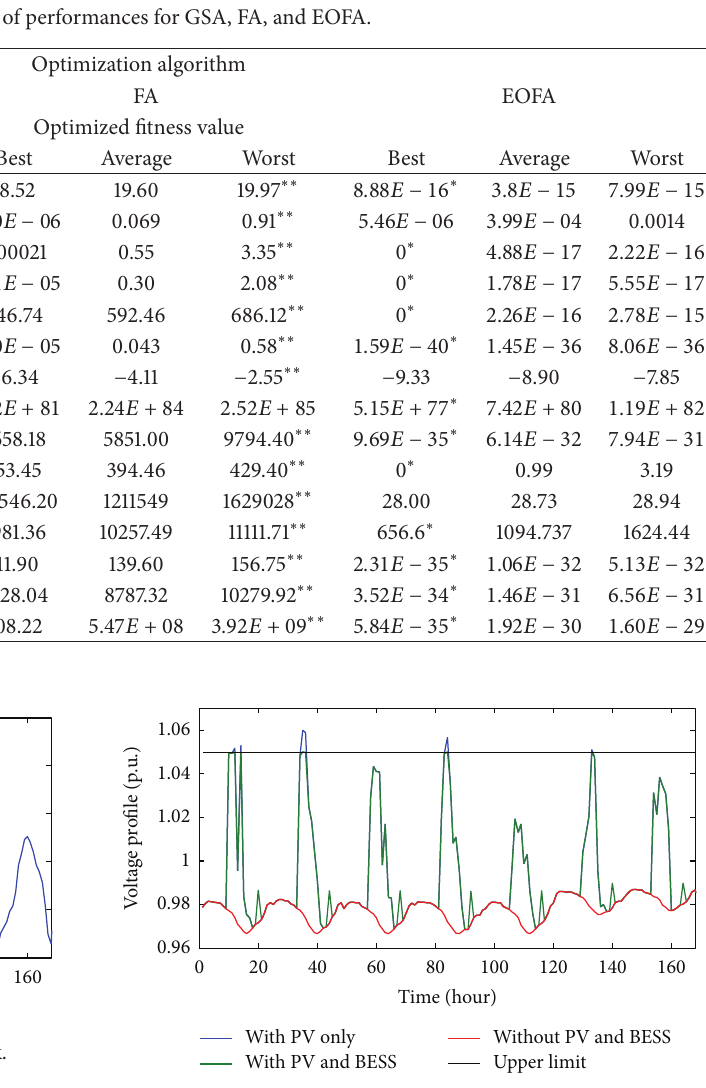
Figure 7: Effect of PV and BESS on PVDG bus voltage